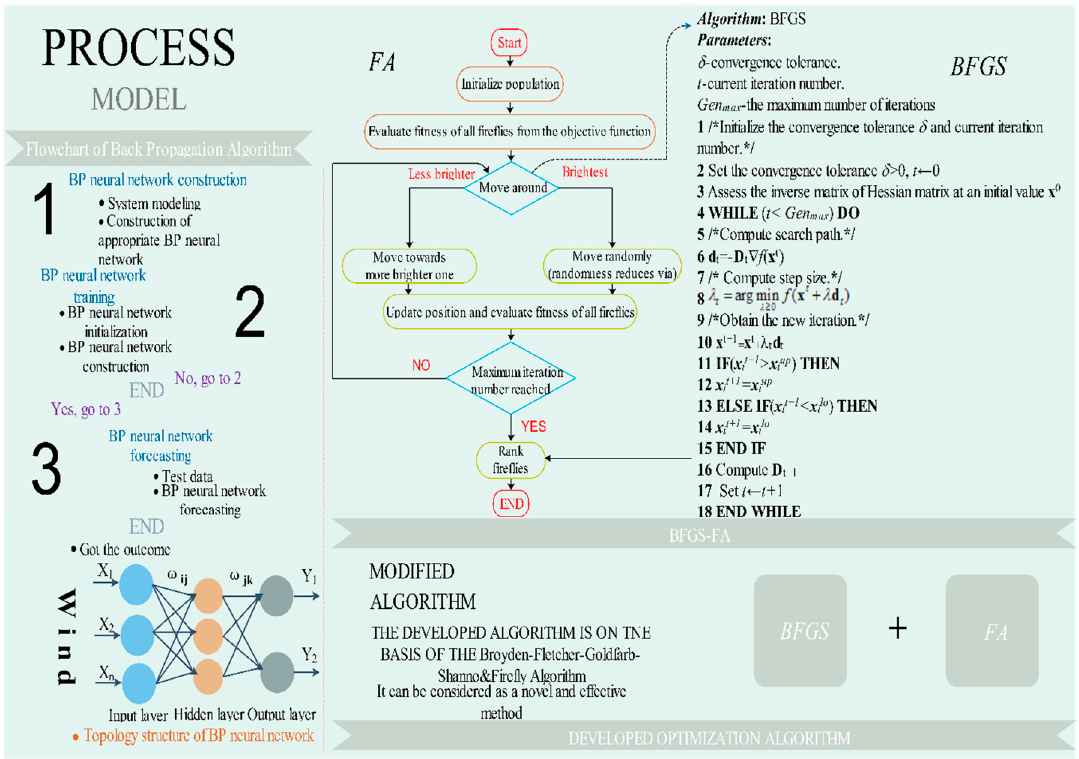
Figure 1. Topology structure and flow chart of BP neural network and the flow chart and structure of the combined BFGS-FA Algorithm.